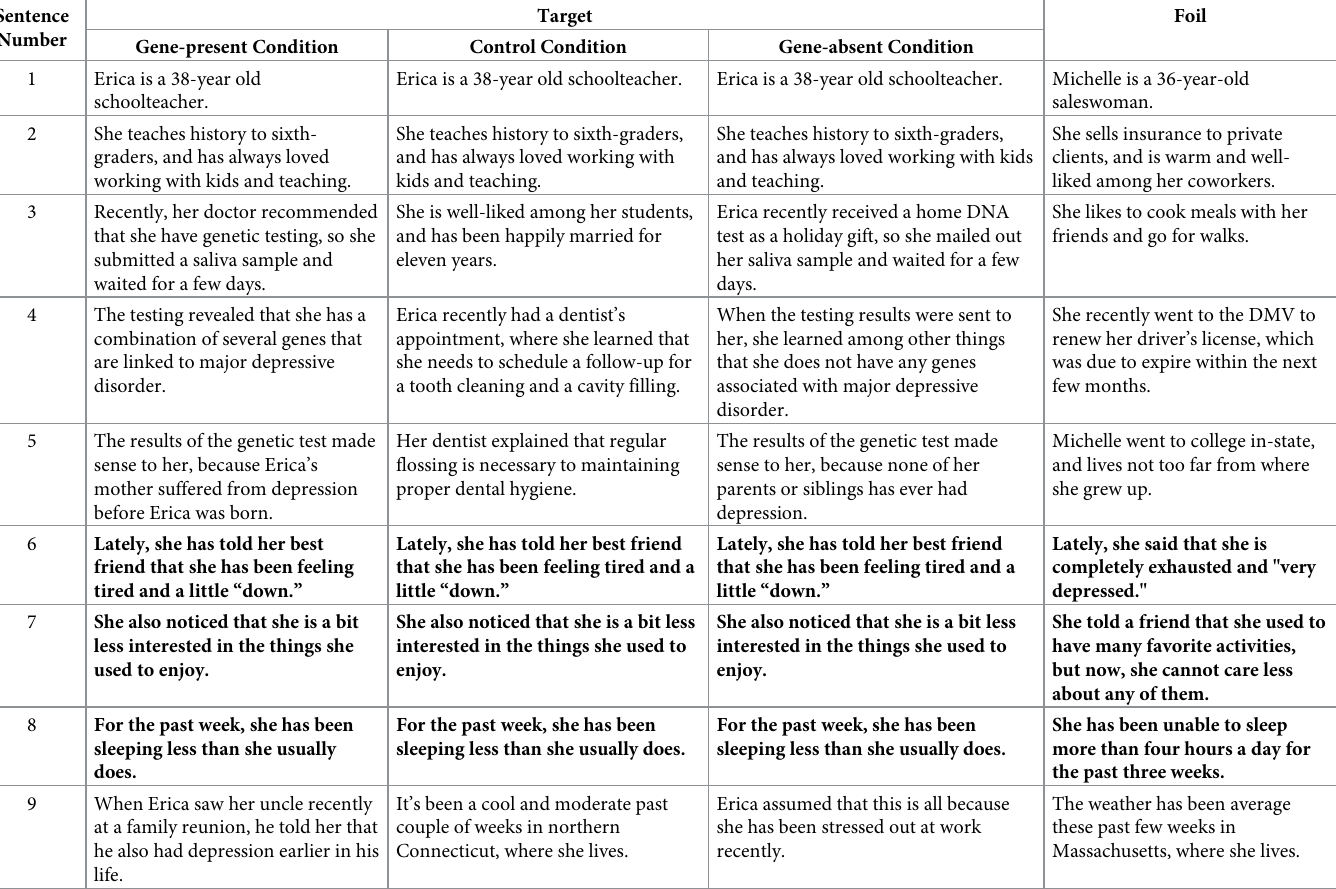
Table 1. Stimuli used in Experiments 1 and 3. Sentence Number